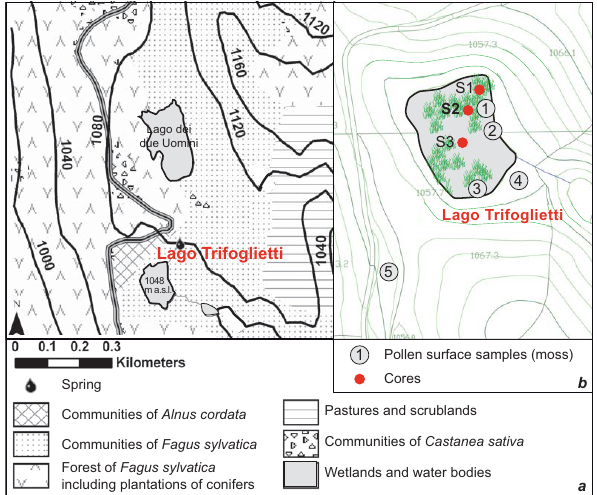
Fig. 2. (a) Actual vegetation map; (b) coring sites, surface samples and relev´es localisation.